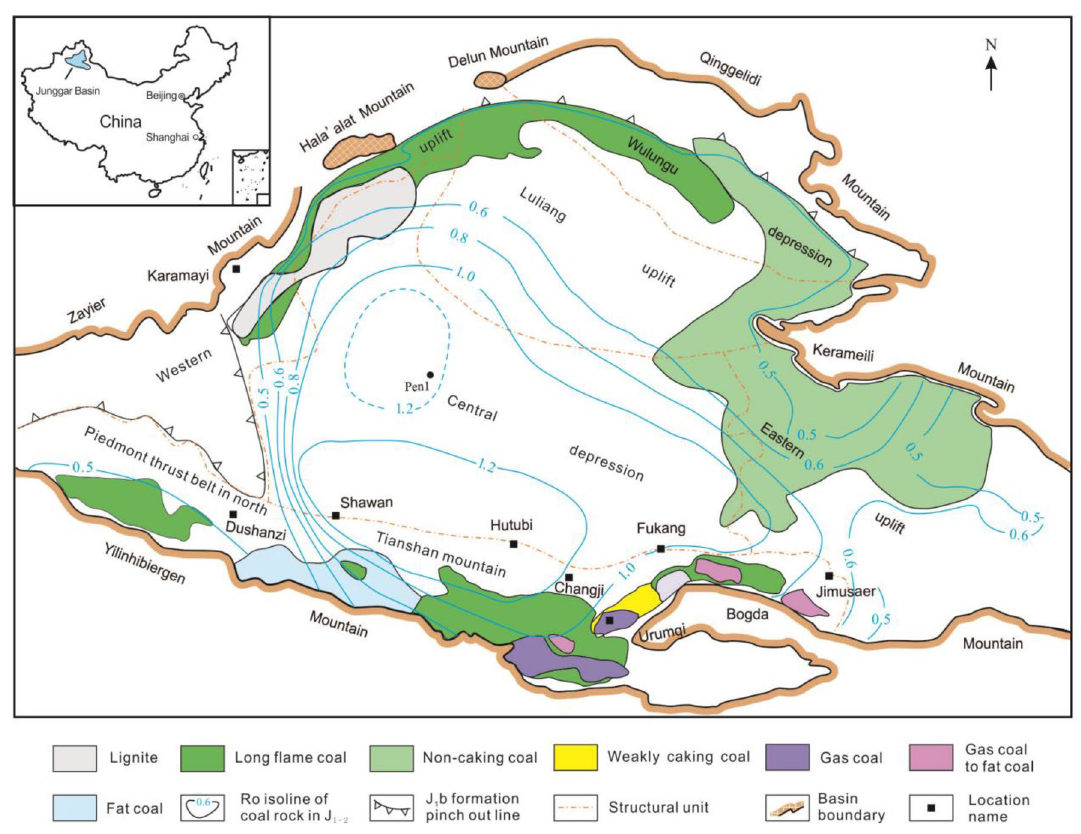
Fig. 1 Structural unit, Ro isolines of middle-lower Jurassic and margin distribution of coal types in Junggar